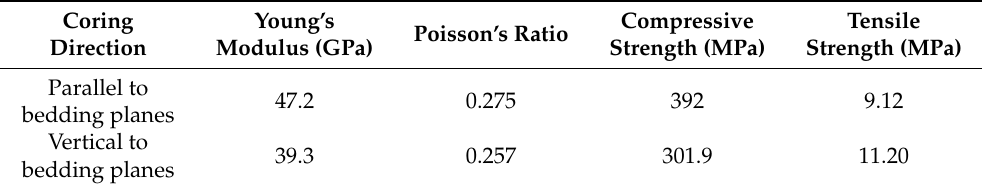
Table 1. Mechanical parameters of rock specimens.